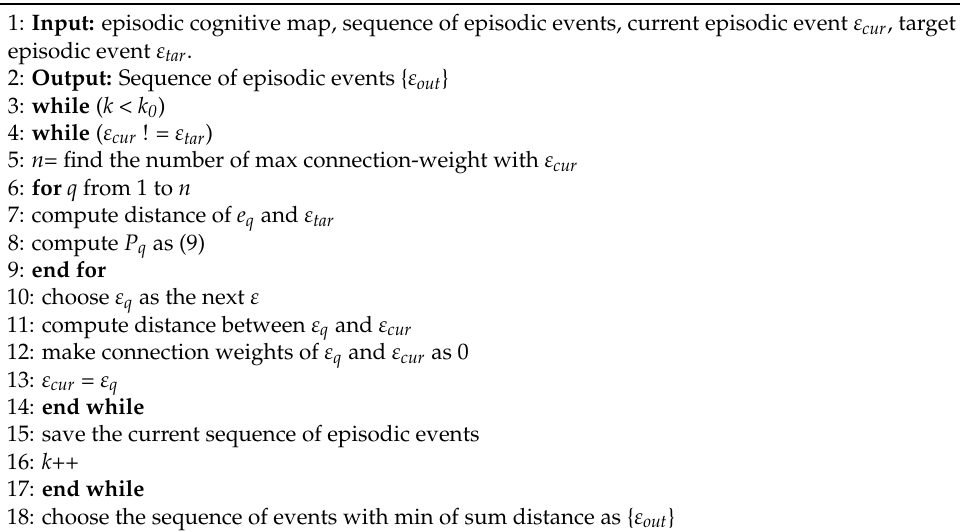
Table 1. Path planning algorithm using episodic memory based on probabilistic